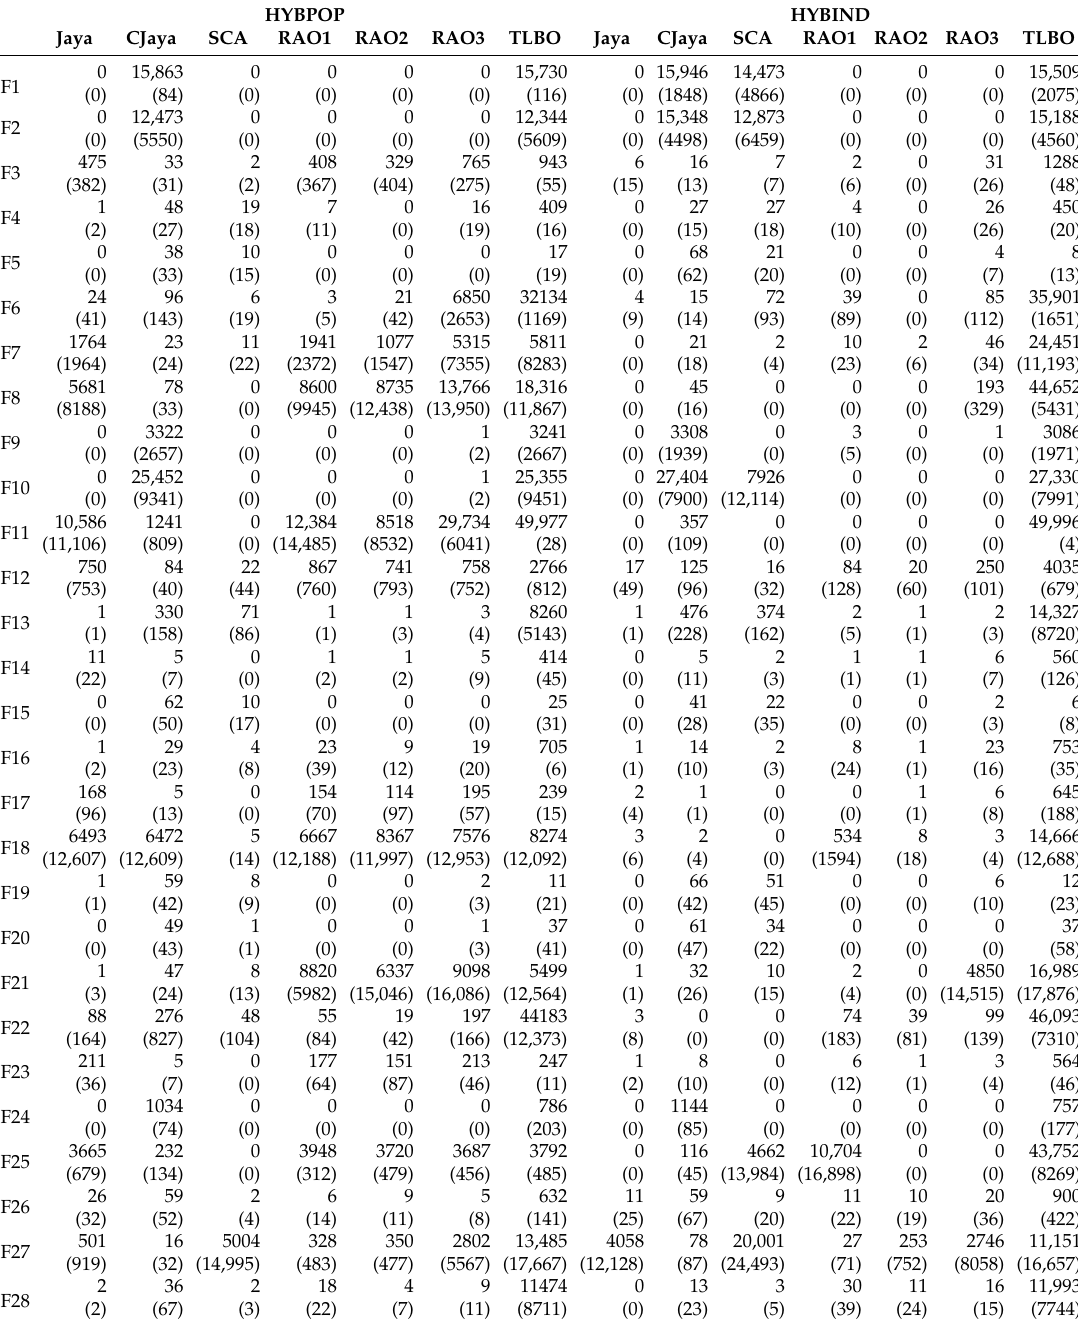
Table 10. Last iteration in which a replacement of the best individual occurs (LtI-BI). The population size is set as